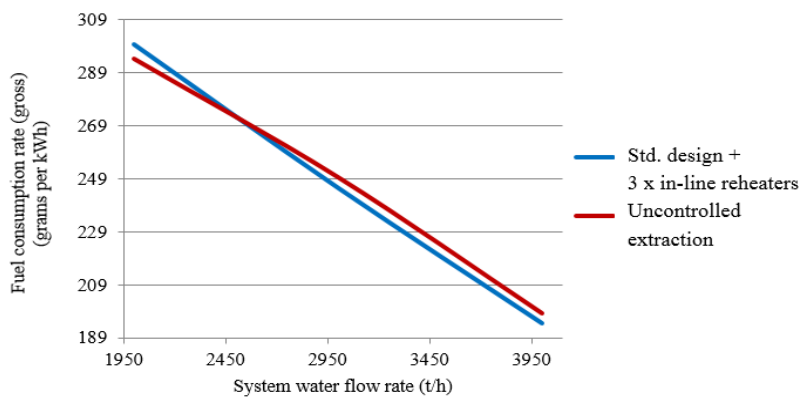
Figure 6. Plots of specific fuel-equivalent flow rates as a function of the system water flow rate for generating unit thermal systems at an outdoor air temperature of +5 °C.